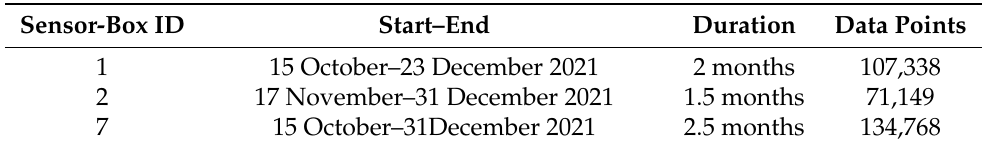
Table 5. Stationary sensor-boxes in Stans, Nidwalden.